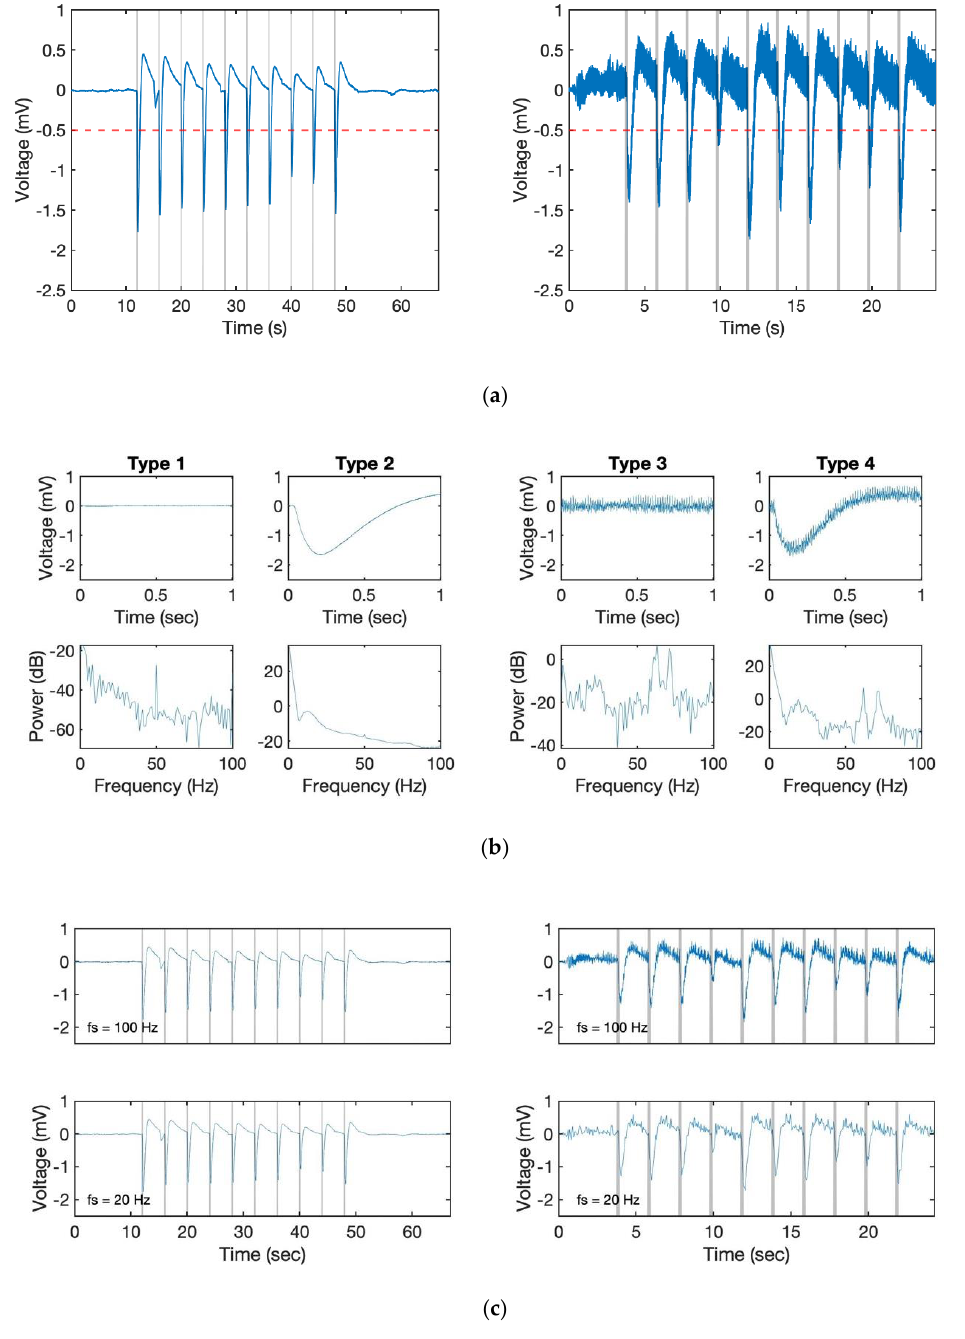
Figure 4. Characteristics of EAG signals recorded on the drone. ( a ) EAG signal when propellers were off (Type 2, left) and on (Type 4, right) with 10 kHz sample rate. The red dashed line is a fixed threshold at −0.5 mV and the grey area represents the odour stimulation (0.25 Hz and 0.5 Hz). ( b ) A typical single odour response (upper row, the odour was applied only in Type 2 and 4) and power spectral density (PSD, lower row) of different types of signal in a second. ( c ) The signal of ( a ) resampled at 100 Hz (upper row) and 20 Hz (lower row) for comparison.